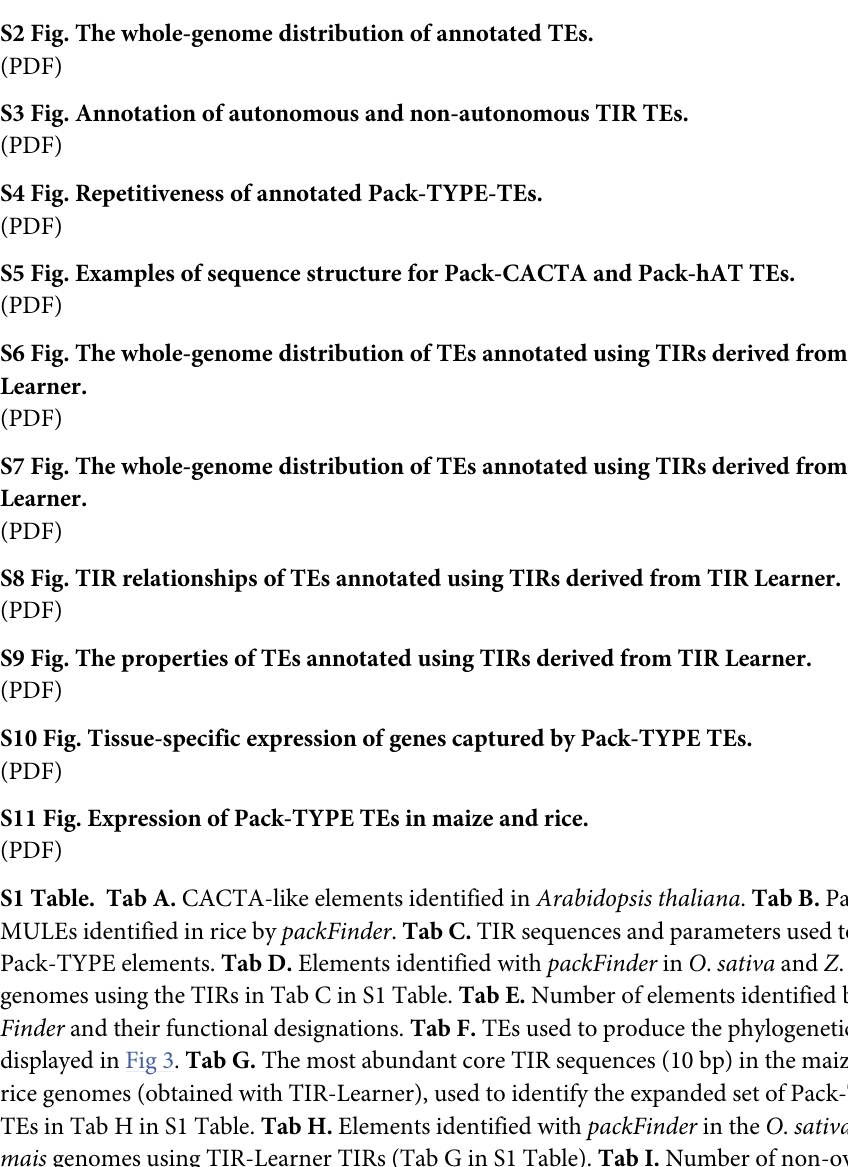
S1 Fig. Benchmarking packFinder against previously annotated Pack-MULEs. (PDF) S2 Fig. The whole-genome distribution of annotated TEs. (PDF) S3 Fig. Annotation of autonomous and non-autonomous TIR TEs. (PDF) S4 Fig. Repetitiveness of annotated Pack-TYPE-TEs. (PDF) S5 Fig. Examples of sequence structure for Pack-CACTA and Pack-hAT TEs. (PDF) S6 Fig. The whole-genome distribution of TEs annotated using TIRs derived from TIR Learner. (PDF) S7 Fig. The whole-genome distribution of TEs annotated using TIRs derived from TIR Learner. (PDF) S8 Fig. TIR relationships of TEs annotated using TIRs derived from TIR Learner. (PDF) S9 Fig. The properties of TEs annotated using TIRs derived from TIR Learner. (PDF) S10 Fig. Tissue-specific expression of genes captured by Pack-TYPE TEs. (PDF) S11 Fig. Expression of Pack-TYPE TEs in maize and rice. (PDF) S1 Table. Tab A. CACTA-like elements identified in Arabidopsis thaliana . Tab B. Pack- MULEs identified in rice by packFinder . Tab C. TIR sequences and parameters used to identify Pack-TYPE elements. Tab D. Elements identified with packFinder in O . sativa and Z . mais genomes using the TIRs in Tab C in S1 Table. Tab E. Number of elements identified by pack- Finder and their functional designations. Tab F. TEs used to produce the phylogenetic trees displayed in Fig 3. Tab G. The most abundant core TIR sequences (10 bp) in the maize and rice genomes (obtained with TIR-Learner), used to identify the expanded set of Pack-TYPE TEs in Tab H in S1 Table. Tab H. Elements identified with packFinder in the O . sativa and Z . mais genomes using TIR-Learner TIRs (Tab G in S1 Table). Tab I. Number of non-overlap- ping maize and rice loci captured by each Pack-TE identified by BLAST. Tab J. Enrichment analysis of the genes captured by Pack-TYPE TEs. Tab K. Number of Pack-TYPE TEs overlap- ping